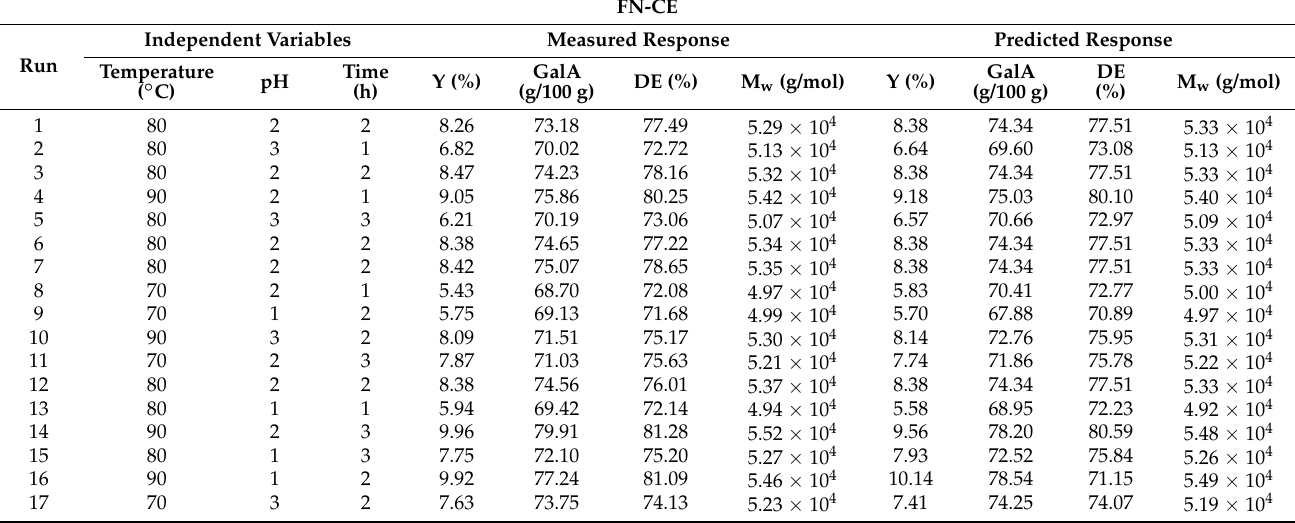
Table A1. Box–Behnken experimental design matrix with measured and predicted